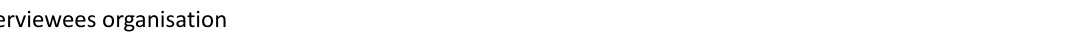
Table 3. Profile of interviewees